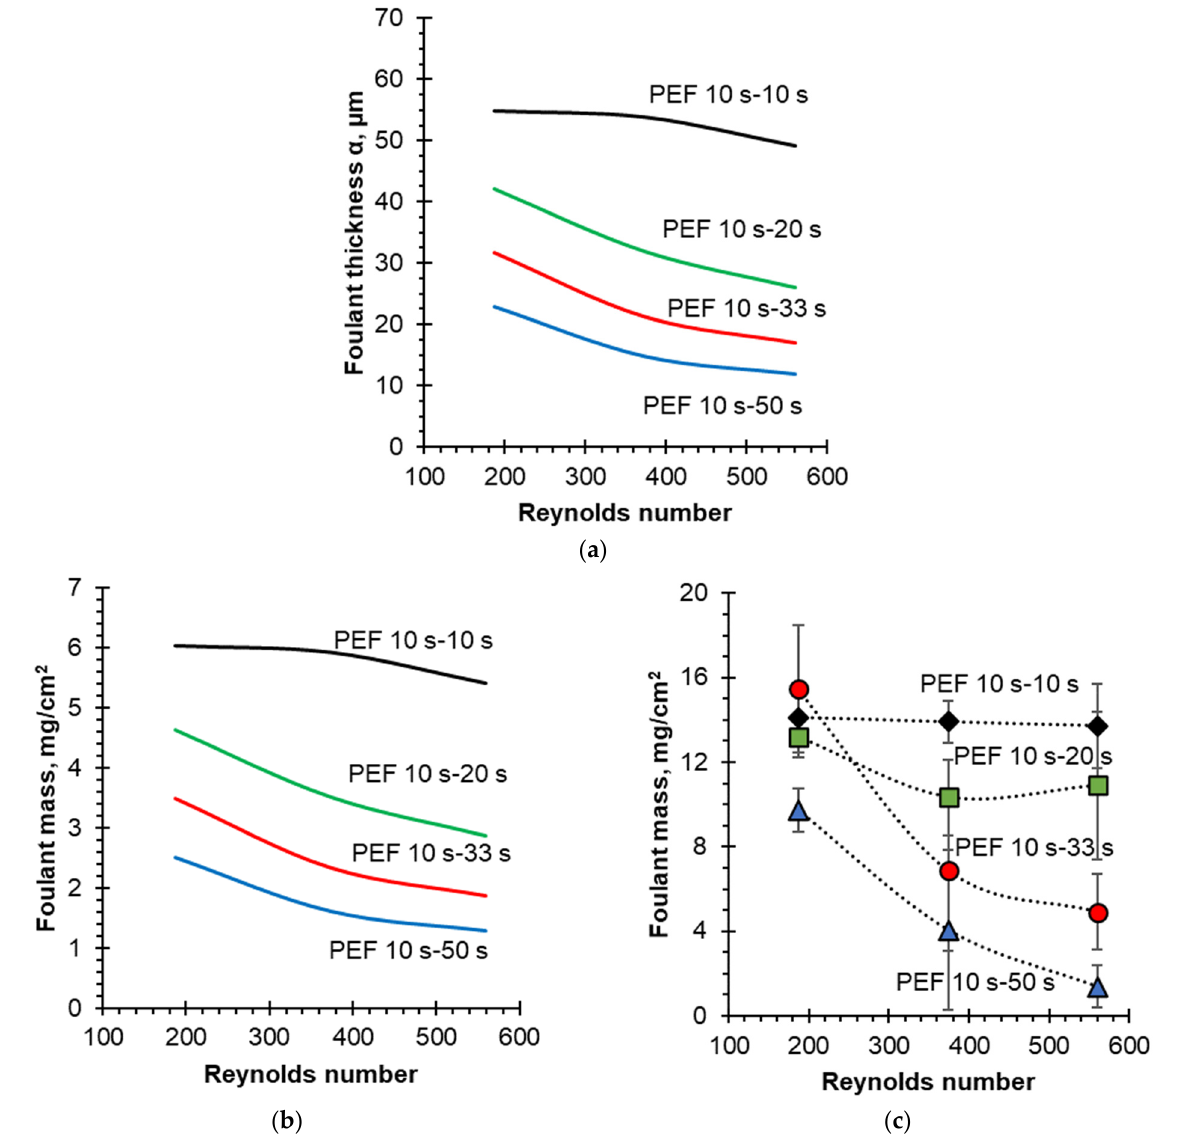
Figure 10. The calculated thickness ( a ) and the mass ( b ) as well as the experimental mass ( c ) of the protein deposit layer vs. the Reynolds number for different PEF modes. The mass of protein is normalized to the active membrane surface area.